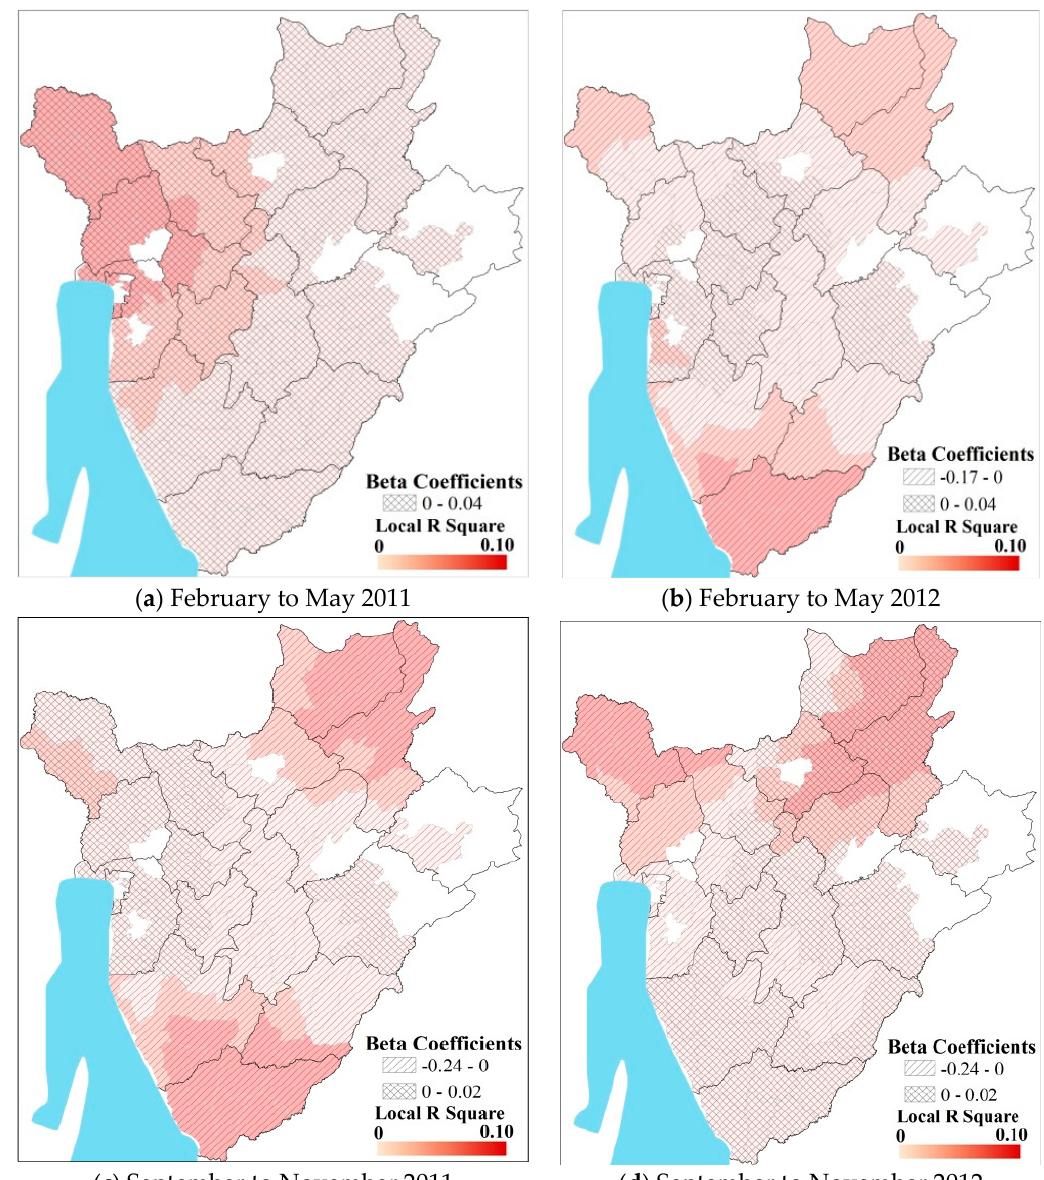
Figure 2. Results of Geographically Weighted Regression (GWR) analysis during the wet seasons ( a ) February to May 2011; ( b ) February to May 2012; ( c ) September to November 2011; ( d ) September to November 2012.